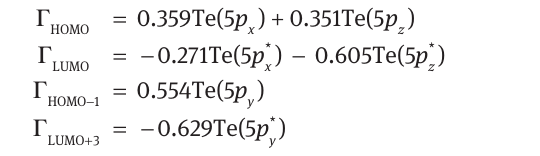
( Γ → M → Y → Γ → X → H ′ → M). Γ→ X corresponds to across the chain. From the band structure, the effective